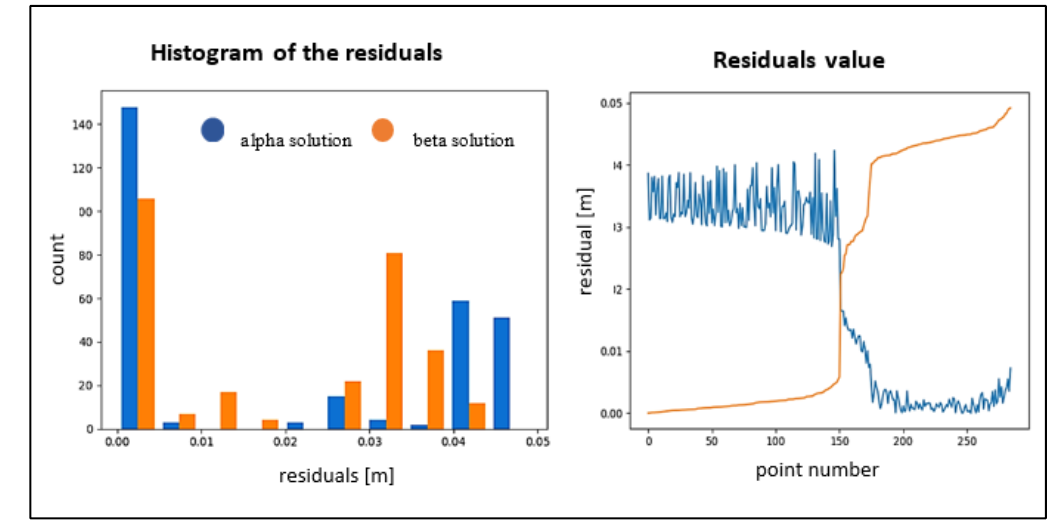
Figure 13. Concrete slabs of a retaining wall.